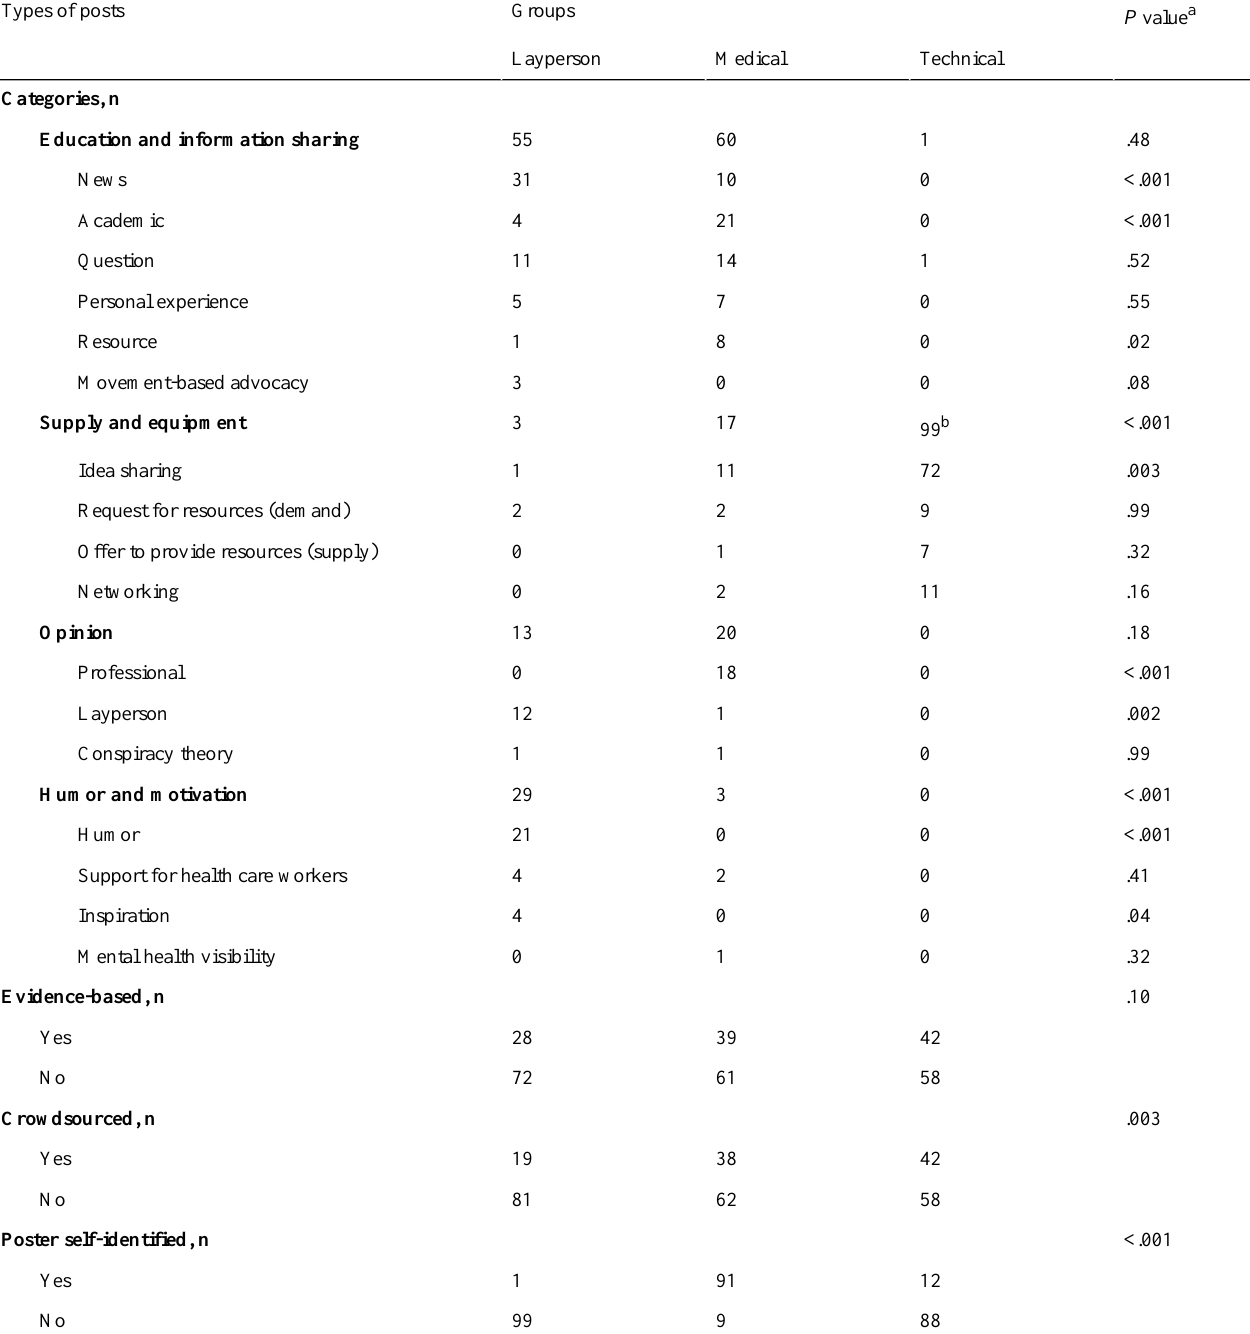
Table 6. Comparison of the characteristics of the top 100 posts by group